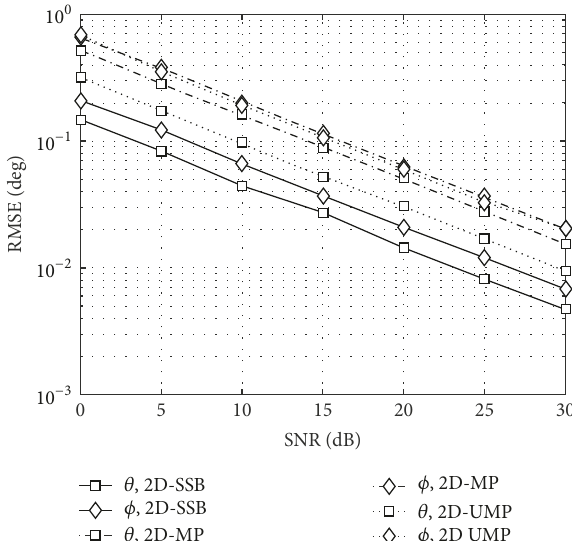
Figure 4: RMSEs of azimuth and elevation angles against with SNR for correlated sources, where (𝜃 1 ,𝜙 1 ) = (25 ∘ ,55 ∘ ) and (𝜃 2 , 𝜙 2 ) = (45 ∘ , 65 ∘ ) .